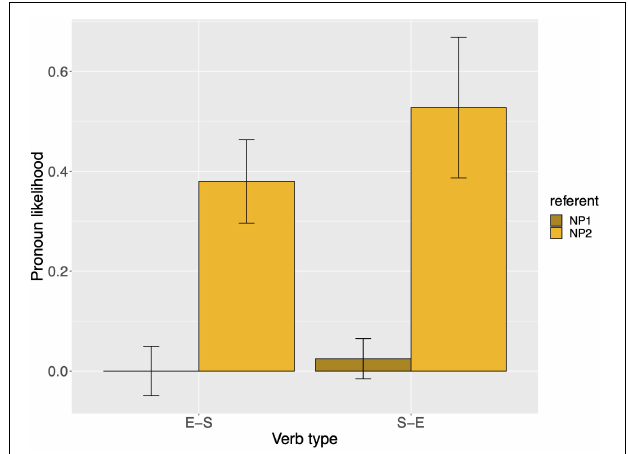
FIGURE 7 | Demonstrative pronoun: probability of using a demonstrative pronoun to refer to NP1 and NP2, per verb type, for Experiment 2. These bars represent the pronoun production likelihoods (and are therefore based on the free-prompt data). Error bars are by-participant and represent 95% confidence intervals based on normalized data (Morey, 2008; Chang, 2013).